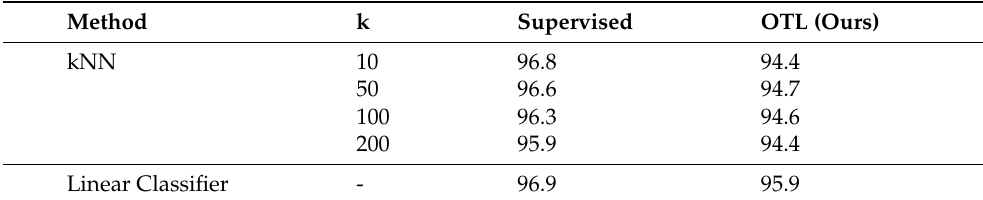
Table 7. EuroSAT : Land Use and Land Cover Classification with